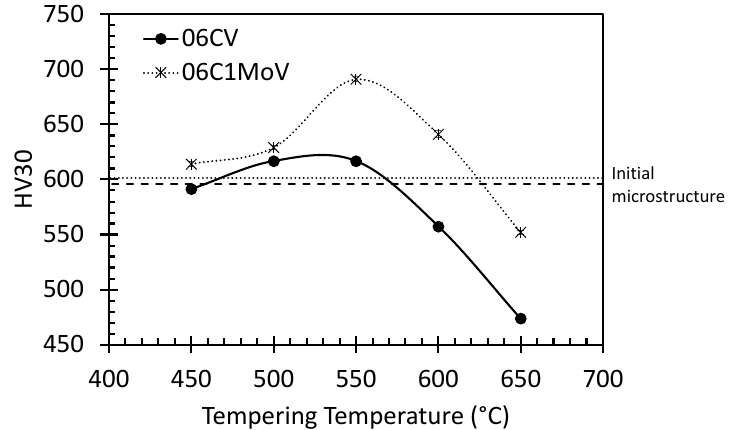
± 10) results as a function of tempering Figure 12. HV (±10) results as a function of tempering temperature. Figure 12. HV (